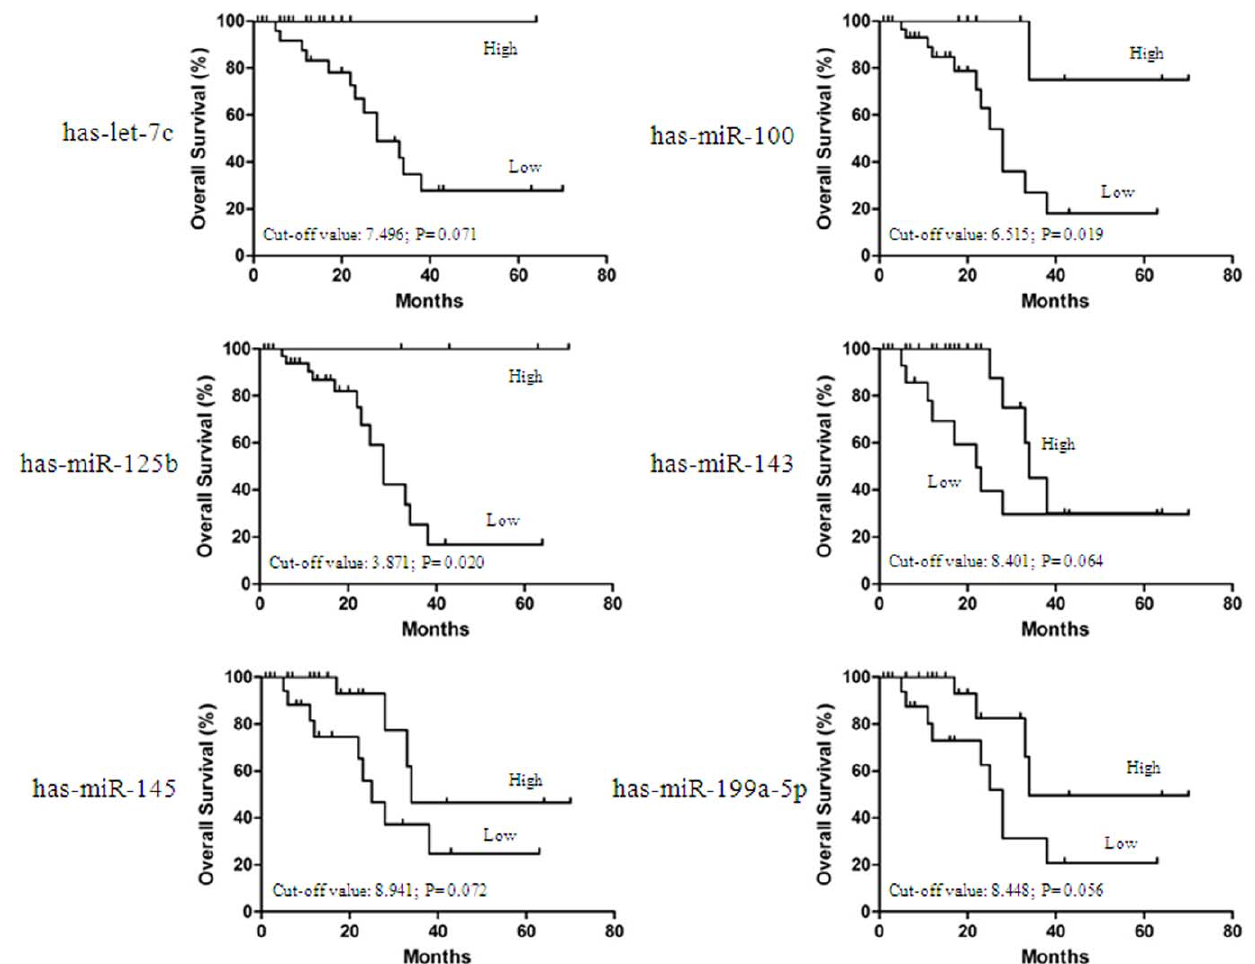
Figure 4. Kaplan-Meier estimates of overall survival in 44 patients with stage small cell carcinoma of the cervix according to has- let-7c (A), has-miR-100 (B), has-miR-125b (C), has-miR-143 (D), has-miR-145 (E) andas-miR-199a-5p expression (F). Has-miR-100 and has-miR-125b down-regulation were significantly associated with poorer survival, and has-let-7c, has-miR-143, has-miR-145 and has-miR-199a-5p down-regulation tended to predict poorer survival, although these results were not statistically significant.